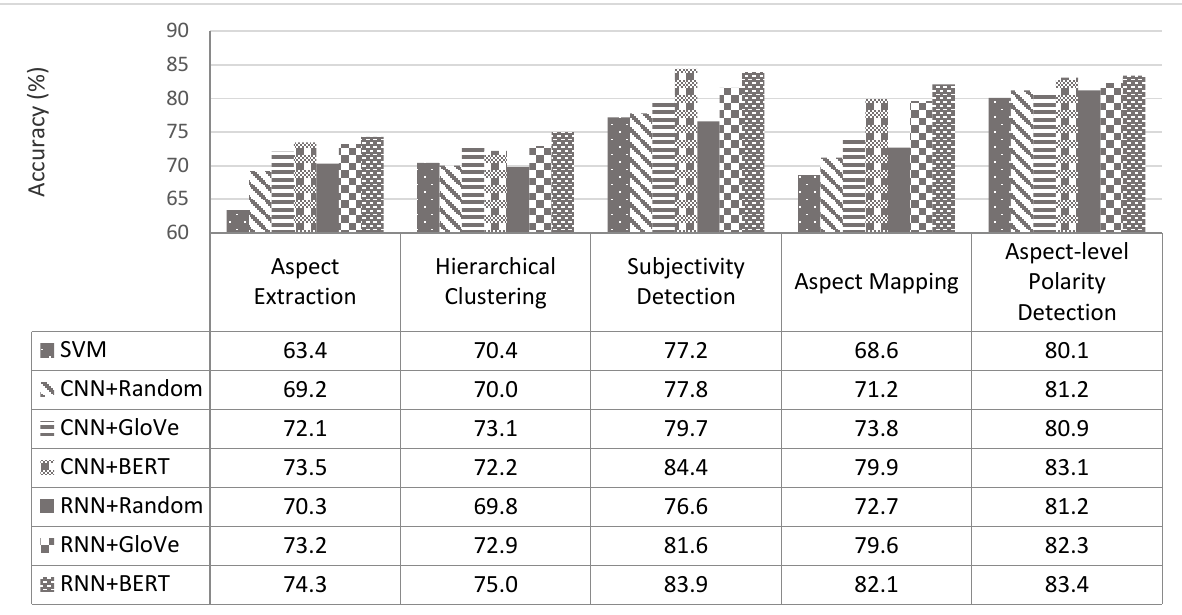
Figure 13. Comparisons of the baseline models for the five research tasks.